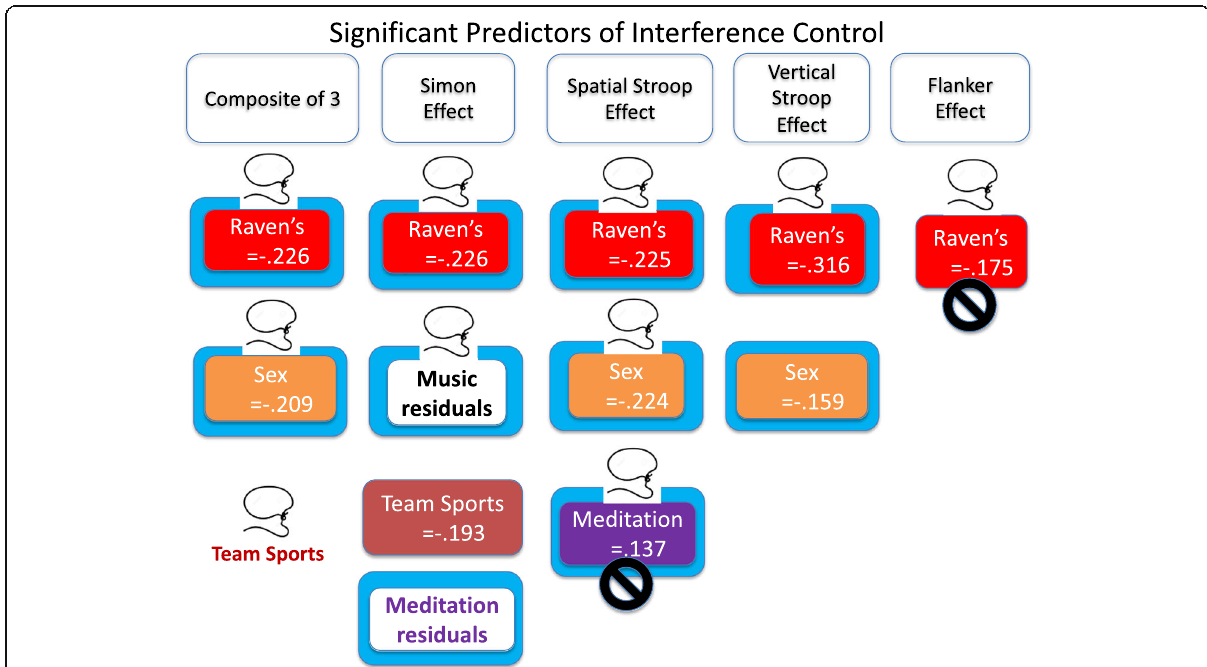
Fig. 3 Embedded colored rectangles are the significant predictors with their beta coefficients for the stepwise regression analyses on the interference scores for each of the four tasks and the composite based on the three that formed a latent variable. The black “ not ” symbols indicate regression coefficients from the stepwise regression that have bootstrapped 95% confidence that include zero ( see text for details). A blue border signifies a significant predicter of the incongruent trial RTs after congruent trial RTs have been regressed out. A lasso signifies a predictor that was significant in the LASSO